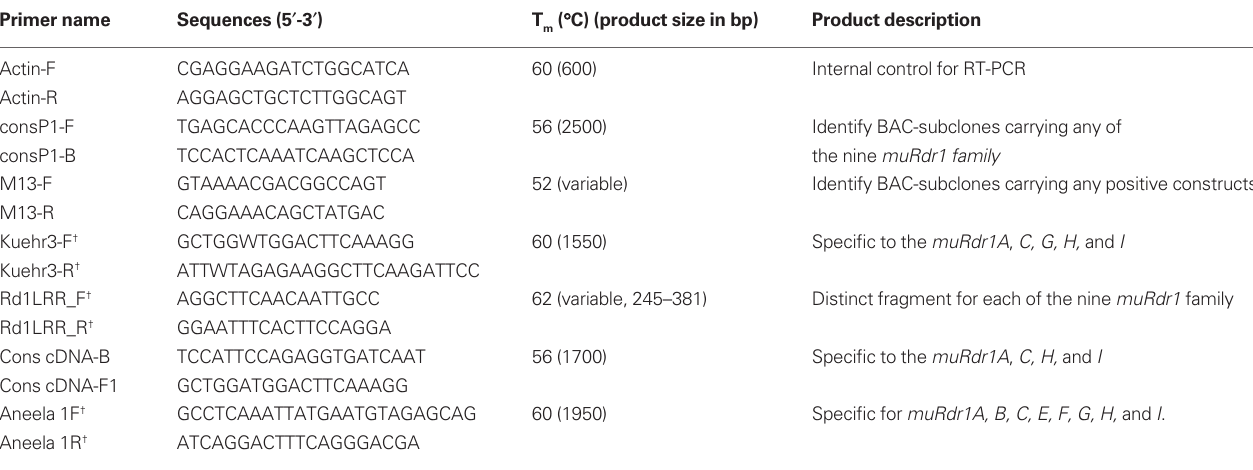
Table A2 | List of primers utilized for selection and analysis of BAC-subclones and TNL